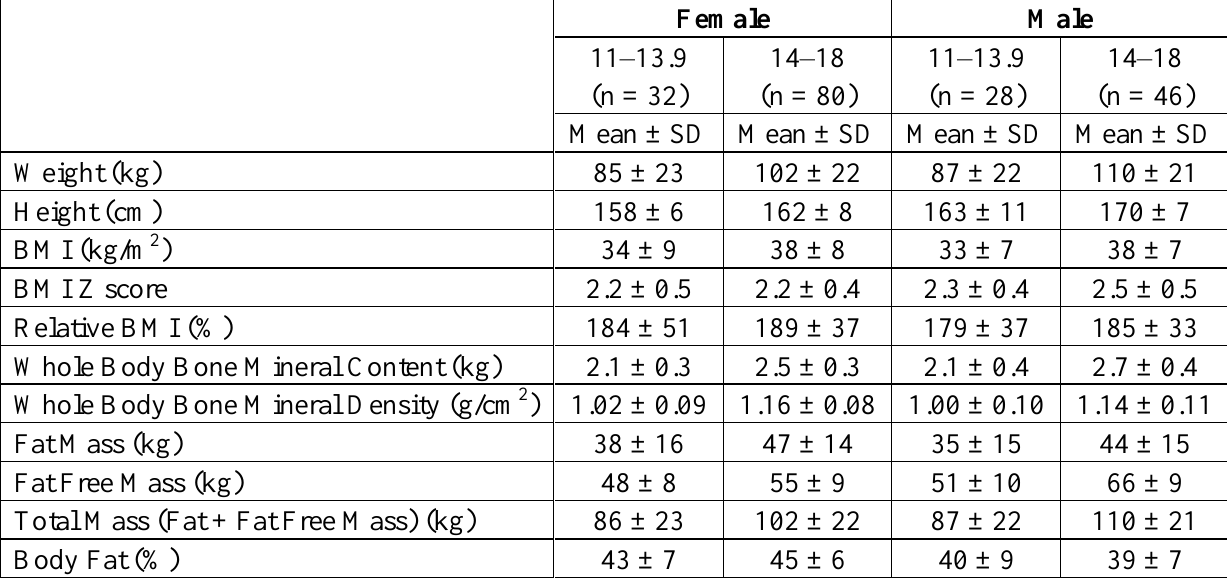
Table 1. Characteristics of the study population by gender and